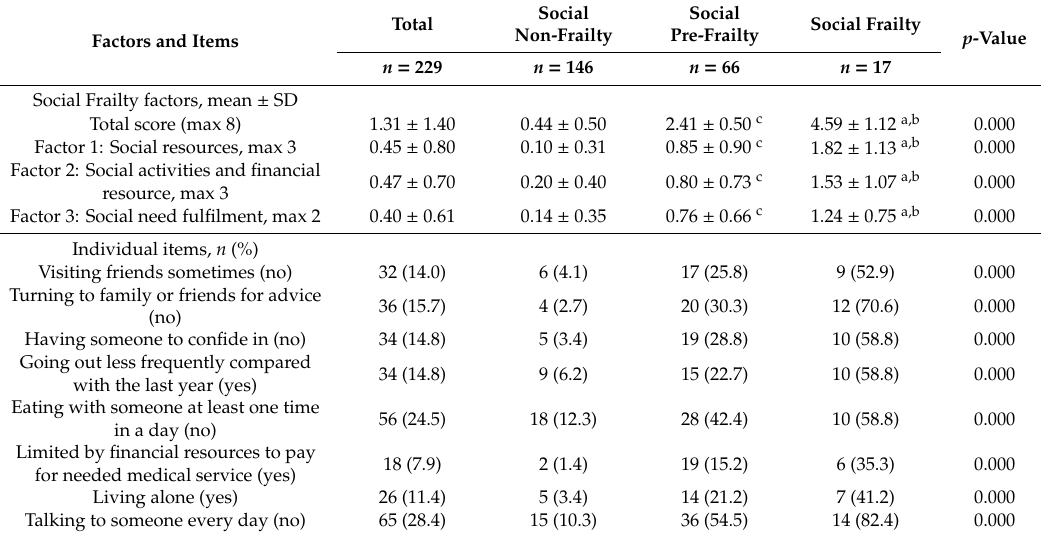
Table 3. Factors and items by social frailty